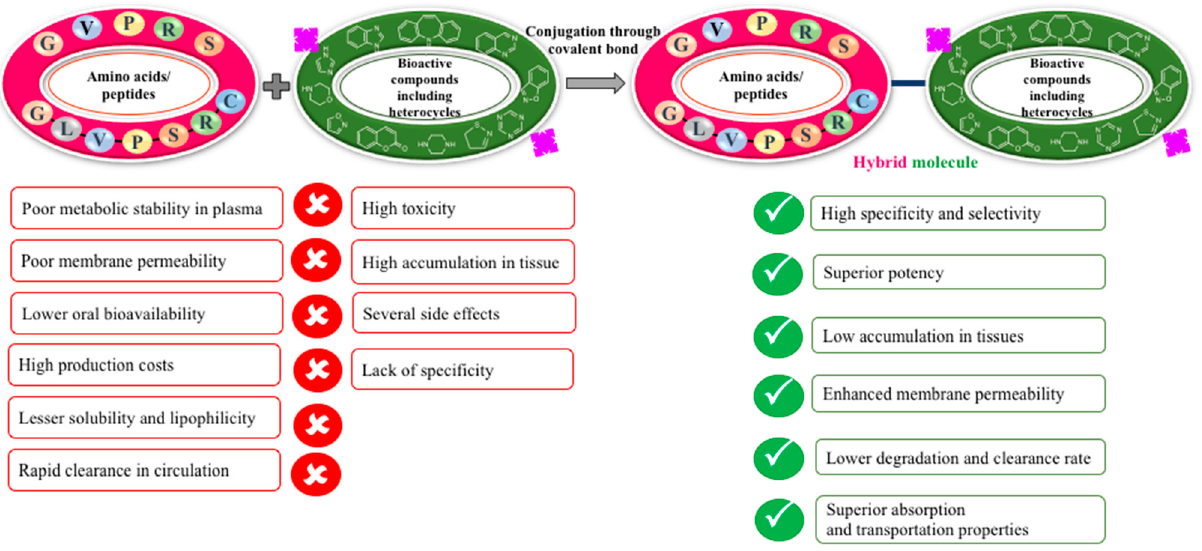
Figure 8. Pros and cons of amino acids/peptides and heterocycles in therapeutic development and the effect of their conjugation.